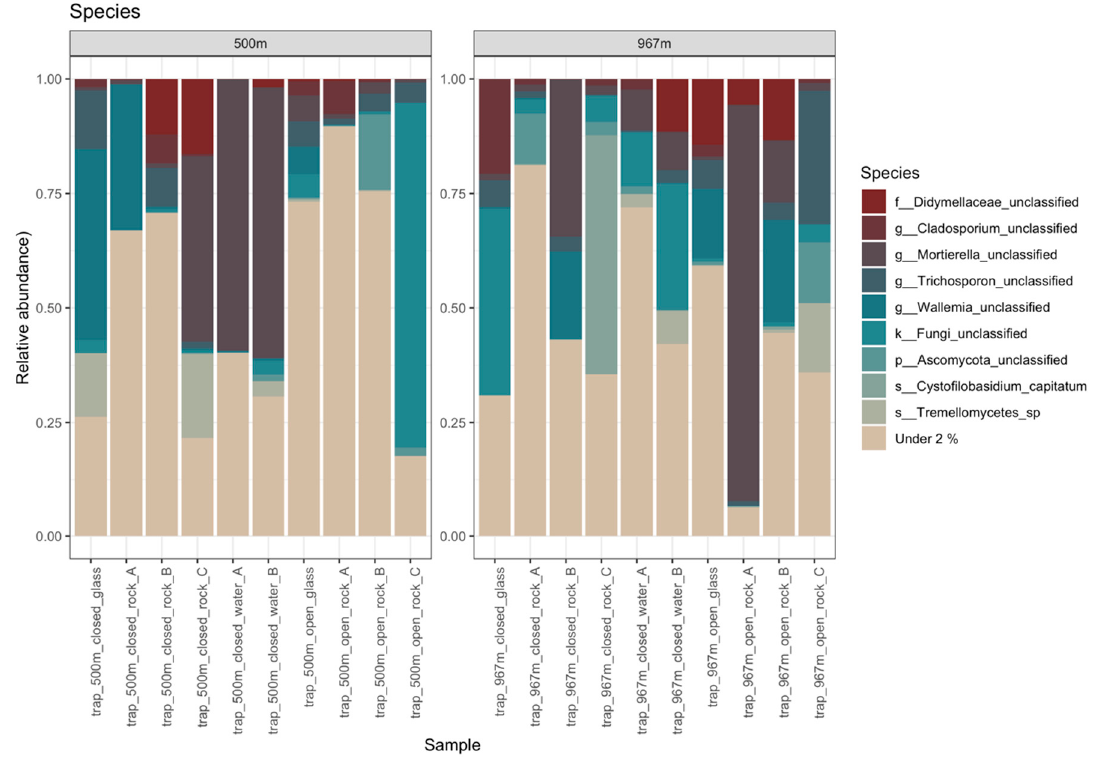
Figure 7. Fungal species in samples from 500 m ( left ) and 967 m ( right ). All the species present at less than 2% relative abundance were merged as group “Under 2%”. In the legend on the right, f, g, k, p, or s in front of the taxon name indicates identification to family, genus, kingdom, phylum, and species level, respectively.